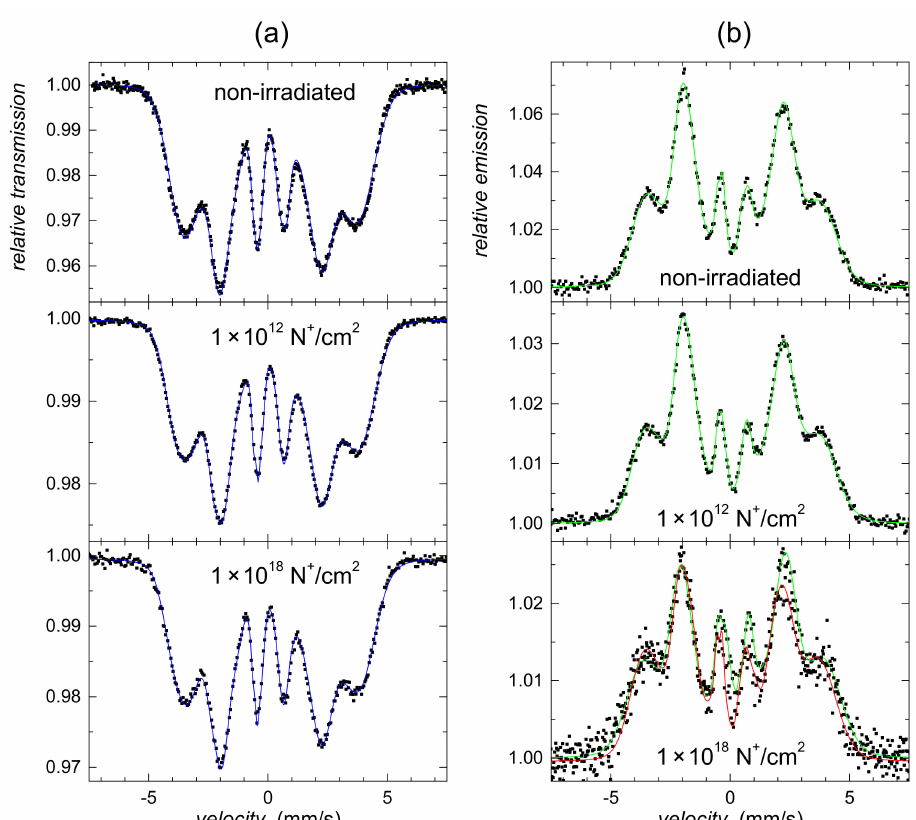
Figure 6. Mössbauer spectra of Fe 74 Cu 1 Nb 3 Si 16 B 6 amorphous metallic alloy irradiated by 110 keV N + ions with the indicated fluences: ( a ) transmission geometry (blue); ( b ) CEMS (green). Mössbauer spectrum taken from the wheel side of the ribbons is shown for comparison in ( b ) (red).